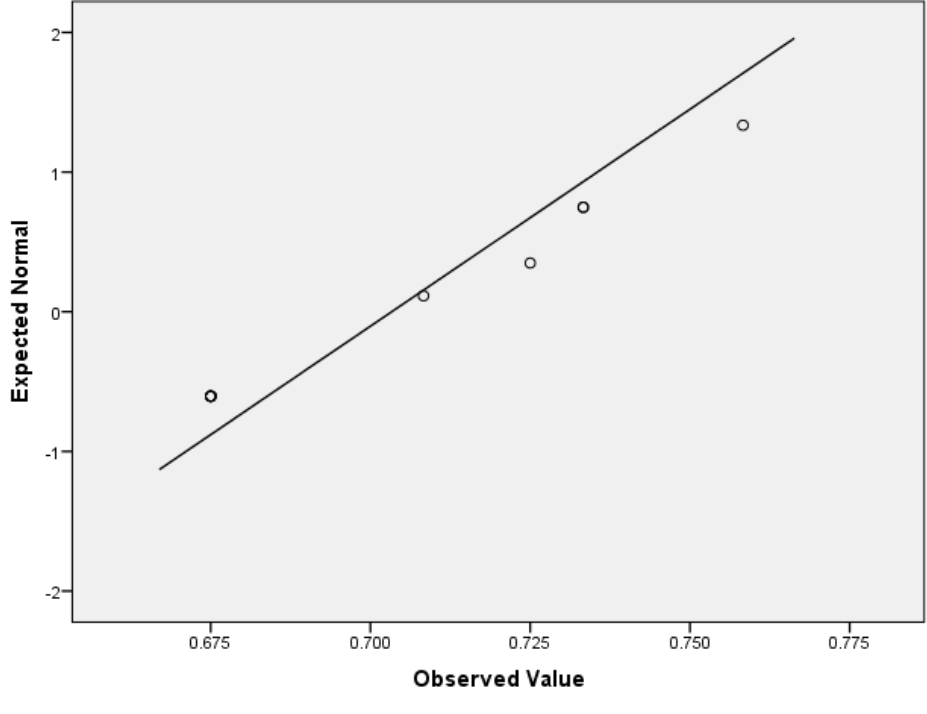
Figure 12. Q-Q-plot for PSD.